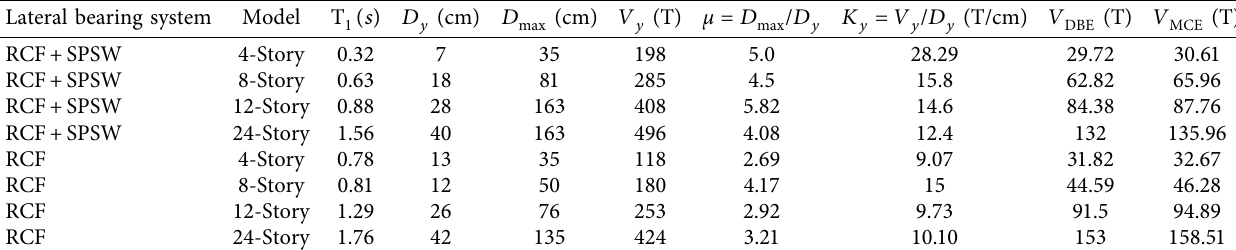
Table 9: Summary of calculation models’ ductility and